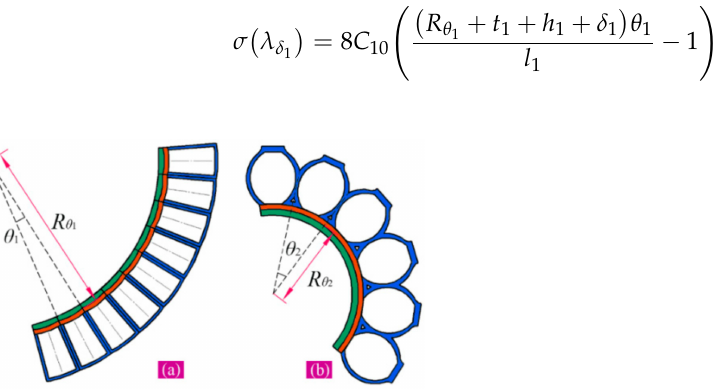
Figure 4. Bending deformation of the two modules: ( a ) module one and ( b ) module